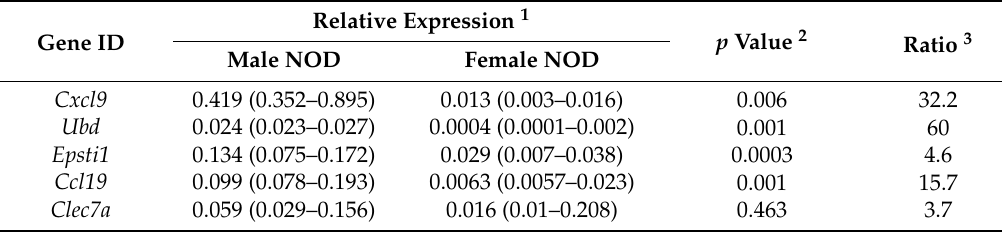
Table 2. Validation of genes upregulated in the context of lacrimal gland disease by qPCR.